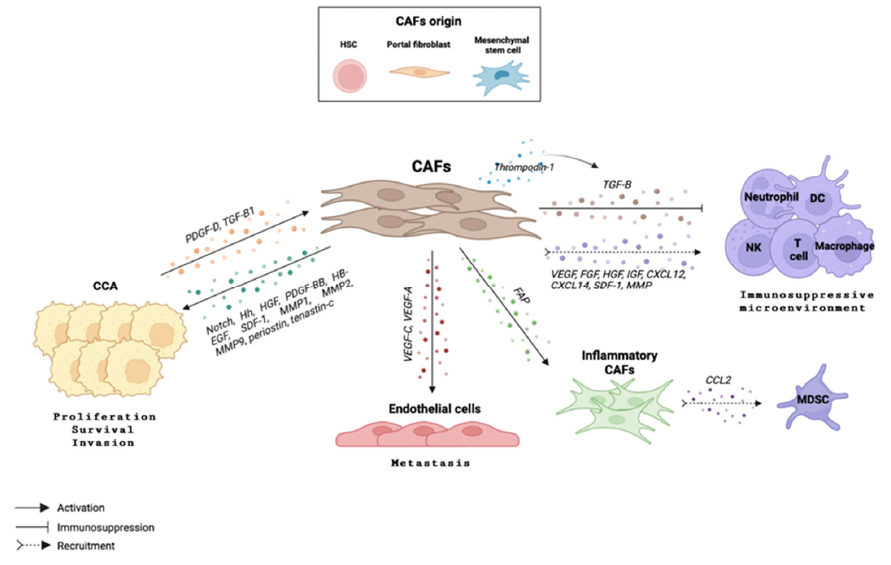
Figure 5. The crosstalk between immune cells and cancer-associated fibroblast (CAFs). CAFs are in continuous interaction with tumor cells and with other components of the tumor microenvironment, promoting tumor progression and metastasis. CAFs can directly induce CCA proliferation, survival and invasion through Notch, Hh, HGF, PDGF-BBB, HB-EGF, SDF-1, MMP1, MMP2, MMP9, periostin and tenascin-c release. Moreover, CAFs can activate endothelial cells via VEGF-C and VEGF-A release, and, hence, promote metastasis. Furthermore, CAFs can induce an immunosuppressive microenvironment by directly producing TGF- β , which is a potent inhibitor of antitumor immunity, as well as by releasing thrompodin-1, which subsequently activates TGF- β . Additionally, FAP + CAFs, which are characterized by an inflammatory phenotype and are the main cells responsible for CCL2 release, enhance MDSC recruitment into the TME to exert their immunosuppressive function. Additionally, CAFs can also recruit immune cells from the bloodstream to the tumor site by releasing VEGF, FGF, HGF, IGF, CCL2, CXCL12, CXCL14, SDF-1 and